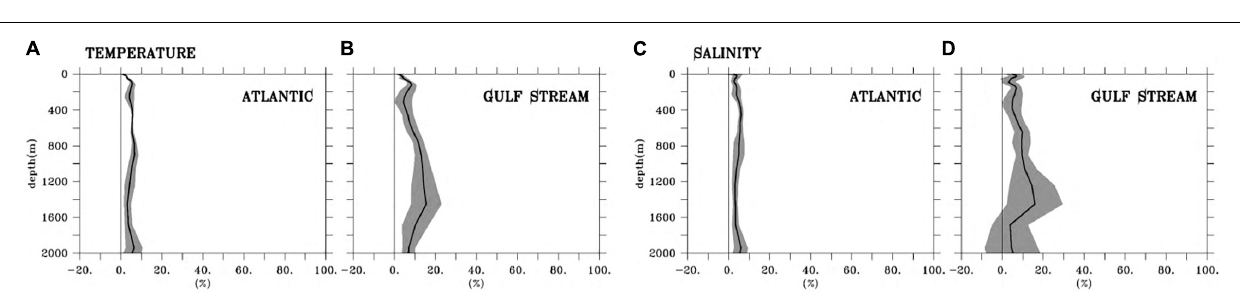
FIGURE 5 | 0–2,000 m temperature and salinity profiles of MSE reduction as compared with the BACKBONE experiment for the ARG2X experiment, area-averaged in (A,C) the Atlantic Ocean and (B,D) the Gulf Stream. The black line is the ensemble mean. Gray indicates the standard deviation of the four members. The unit is in percentage of the MSE from the BACKBONE